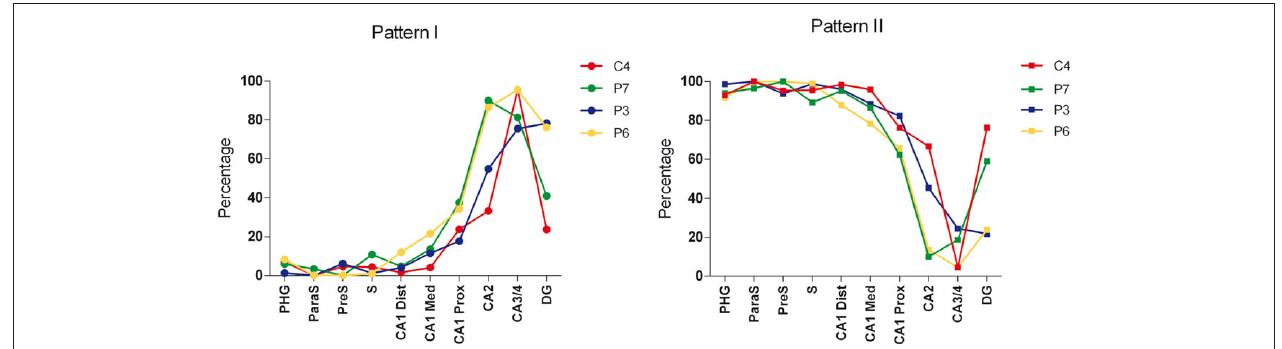
(CA1 Prox), CA1 medial (CA1 Med), CA1 Distal (CA1 Dist), subiculum (S), presubiculum (preS), parasubiculum (paraS) and parahippocampal gyrus (PHG) that includes the entorhinal cortex, perirhinal cortex, or posterior parahippocampal cortex.